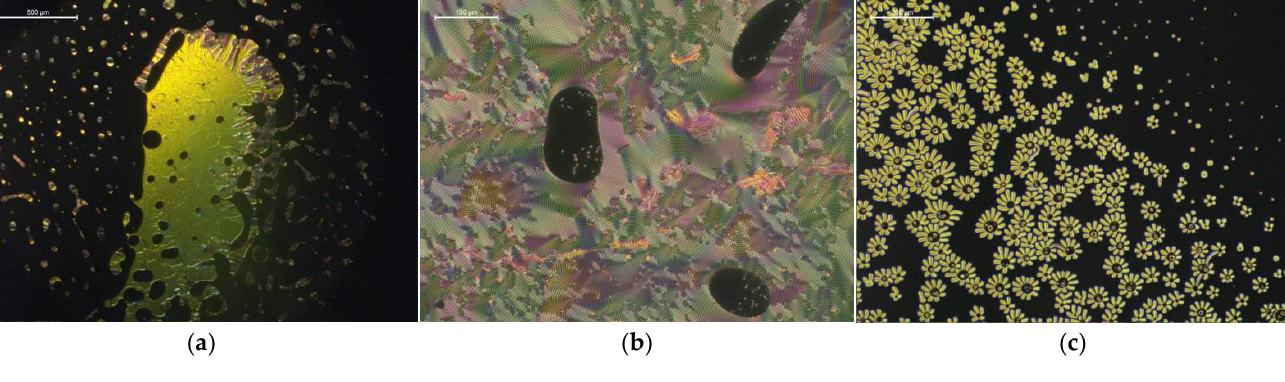
Figure 4. Biphasic regions of isotropic and twisted nematic phases, with various textures induced in the following mixtures of the LCs with the ILs : ( a ) oily streaks texture in a mixture of 1825 + 19.1 wt% [ MenMenIm ][ DCA ] at 90 °C, ( b ) fingerprint (cholesteric gratings) texture in a mixture of E7